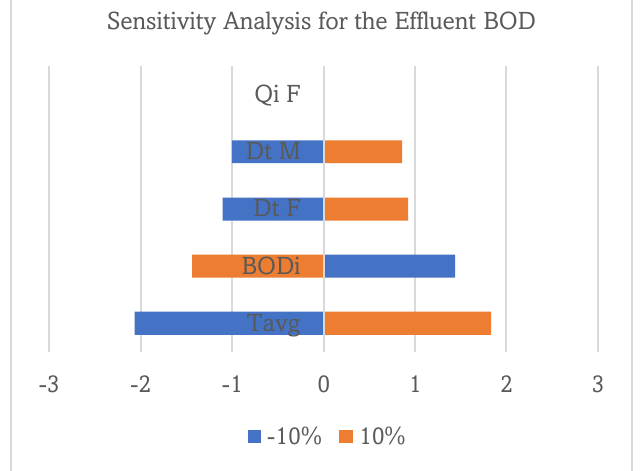
Fig. 6. Sensitivity analysis for the BODe (effluent